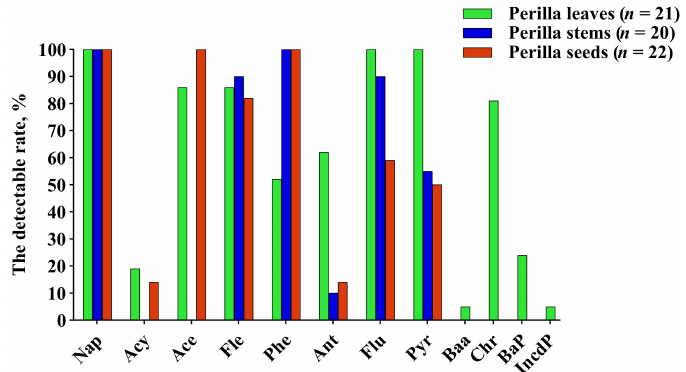
Figure 1. The detectable rate of a single PAH in perilla leaves, stems and seeds.